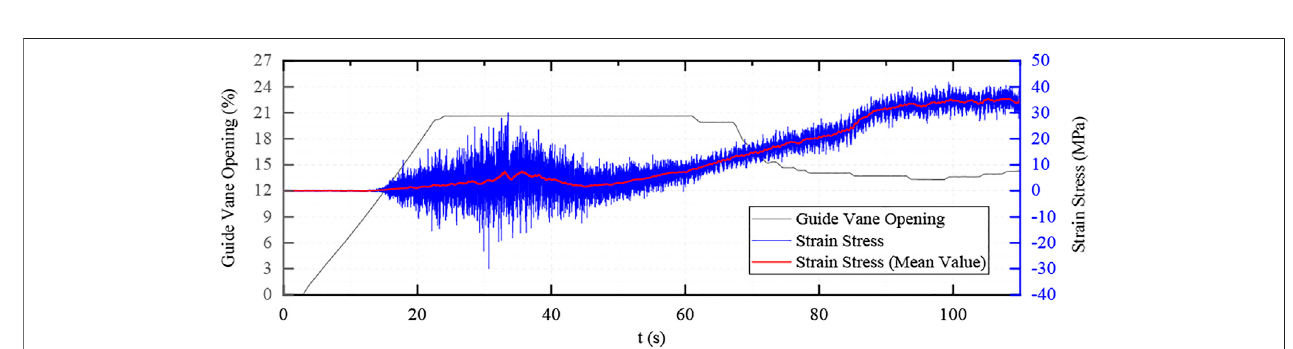
Frontiers in Energy Research |